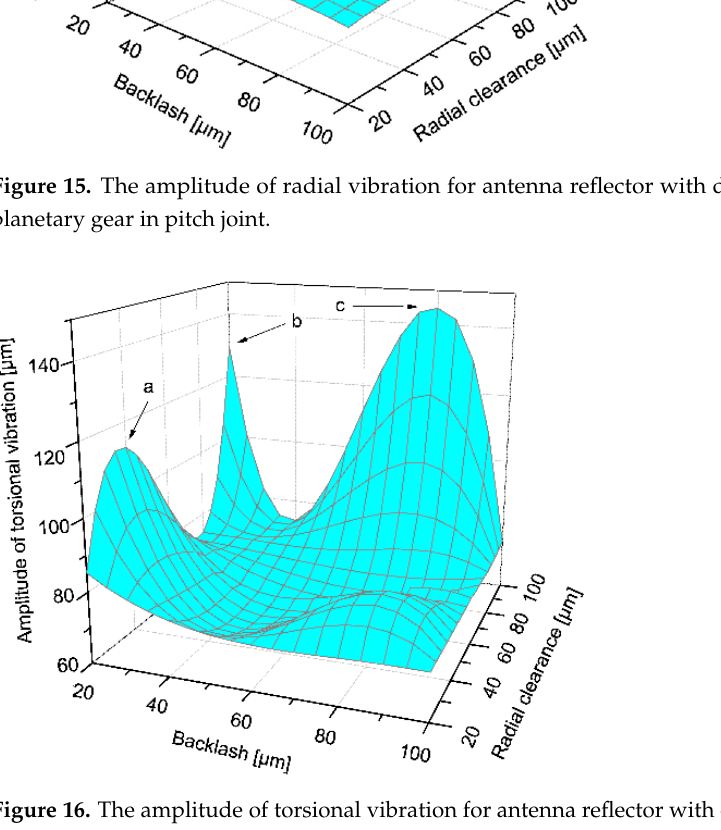
Figure 16. The amplitude of torsional vibration for antenna reflector with different clearance size of planetary gear in pitch joint.